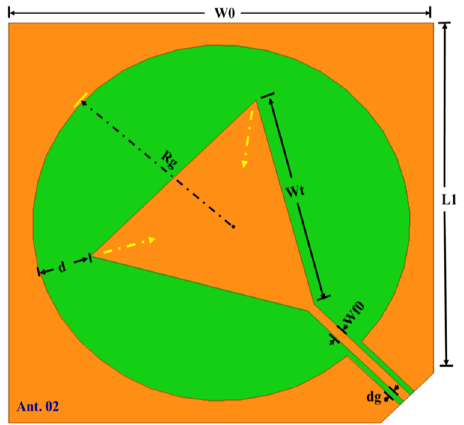
Figure 2. Configuration of the constructed Slot antenna 2.